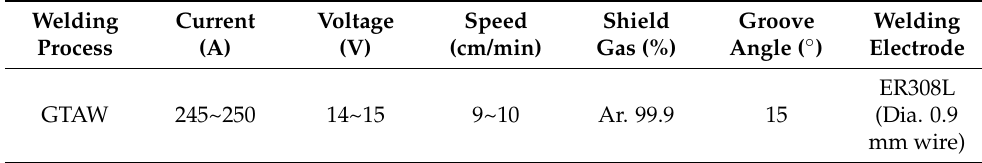
Table 2. Welding conditions of the experimental specimen